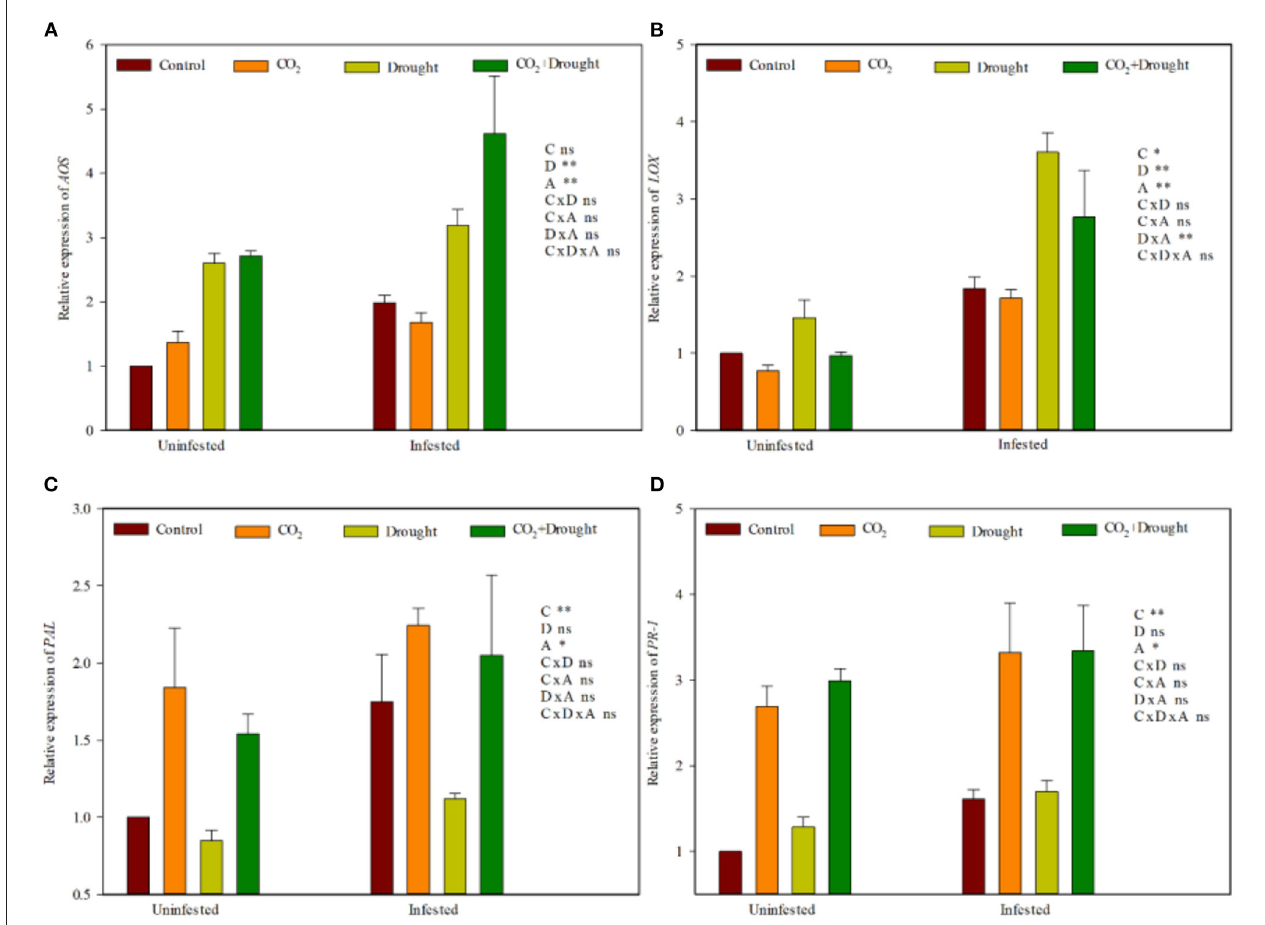
FIGURE 5 | JA- and SA-related gene expression of Triticum aestivum grown under elevated CO 2 and drought conditions with and without aphid infestation. (A) allene oxide synthase ( AOS ); (B) Lipoxygenase ( LOX ); (C) phenylalanine ammonia lyase ( PAL ), (D) pathogenesis-related protein 1 ( PR-1 ). Each value shown represents the mean ( ± SE) of three replicates. P- values are provided for three-way ANOVA on the effects of elevated CO 2 (C) , drought (D) , and aphid (A) treatments on JA- and SA-related gene expression. Significant differences: * P < 0.05; ** P < 0.01; ns, P >